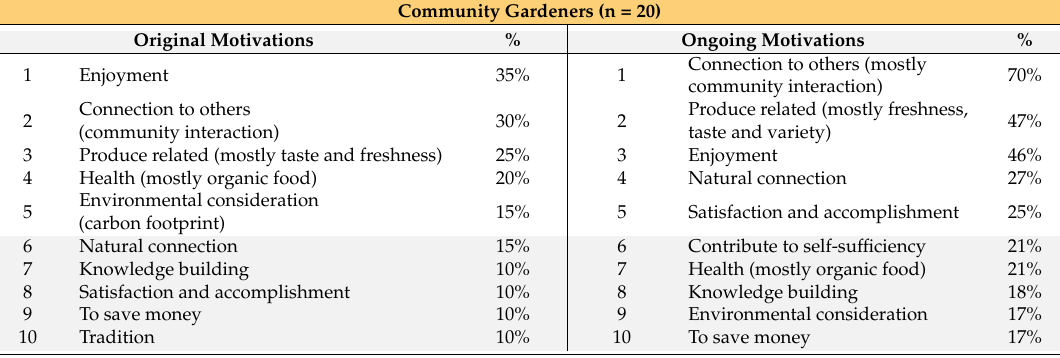
Table 2. The top 10 original and ongoing motivation categories of Edible Gardens community